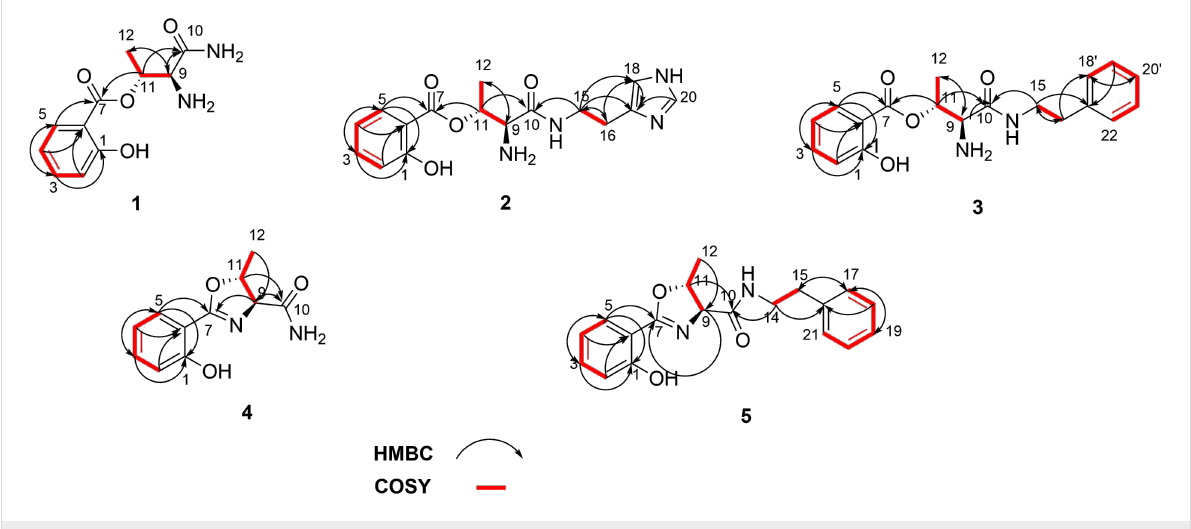
Figure 2: Key HMBC and 1 H- 1 H COSY correlations.